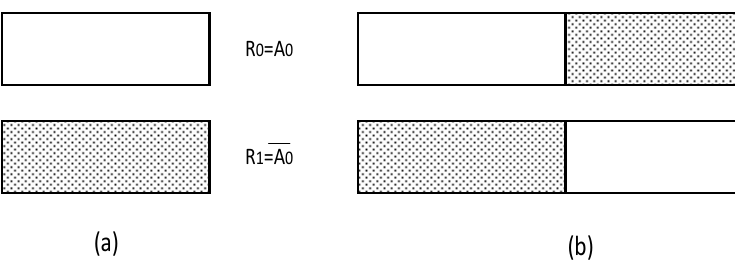
Figure 5. ( a , b ) New reactants with k = 2.